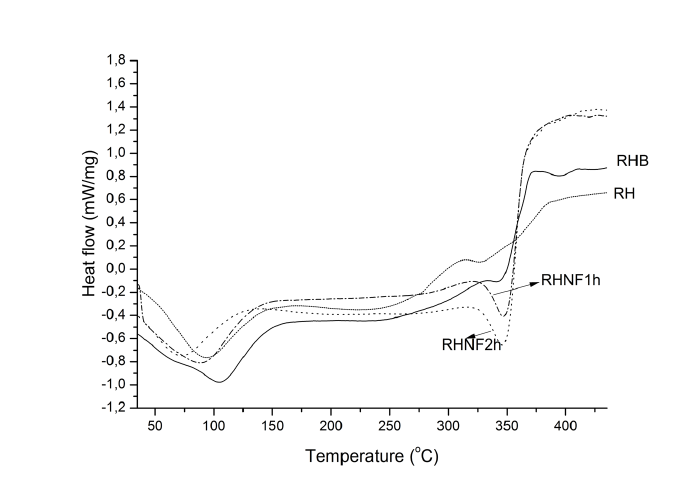
Figure 6. DSC curves of RH, RHB, RHNF1h and